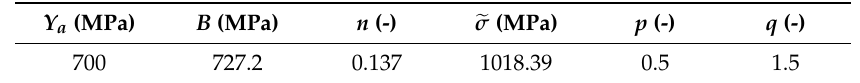
Table 3. Common parameters of the three versions of Voyiadjis–Abed constitutive relations for the investigated high strength steel (HSS).